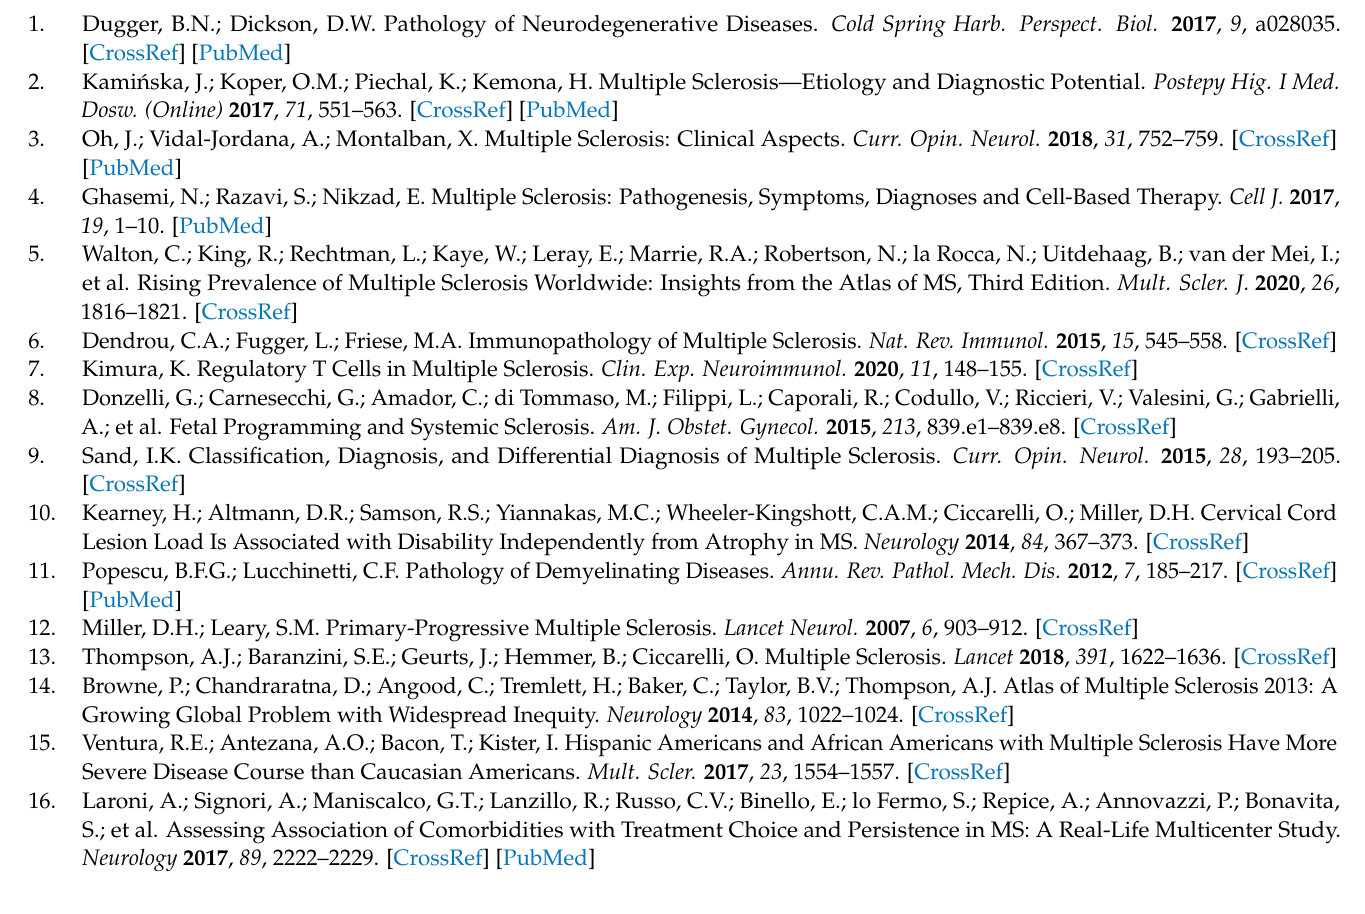
figure preparation, E.G.-M. and M.A.R.-R.; english language revision, P.A.G. and A.M.K. All